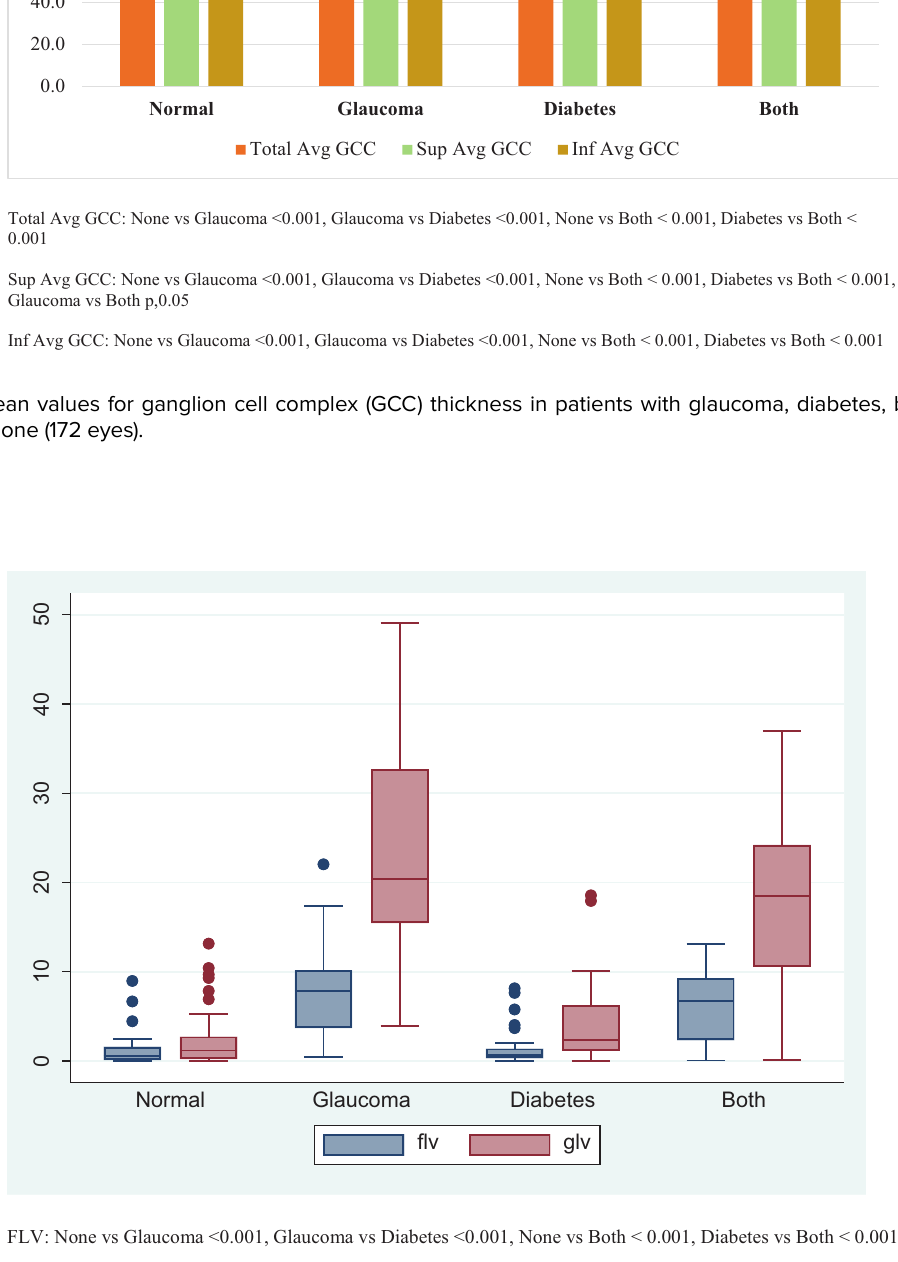
Figure 2. Box plot showing the focal loss of volume (FLV) and global loss of volume (GLV) parameters in patients with glaucoma, diabetes, both (diabetes and glaucoma), and none (172